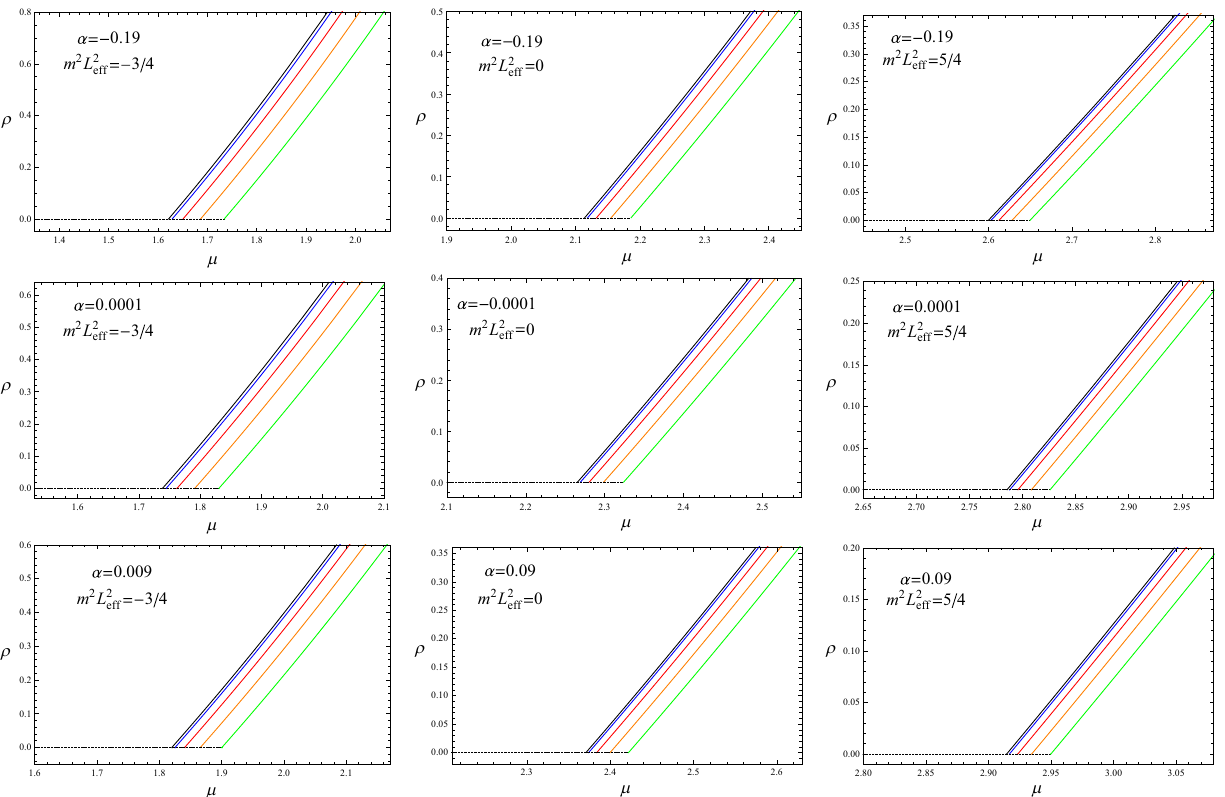
left to right correspond to increasing superfluid velocity, i.e., K = 0 (black), 0 . 25 (blue), 0 . 50 (red), 0 . 75 (orange) and 1 . 00 (green) respec- tively. We scale q = 1 and r s = 1 in the numerical